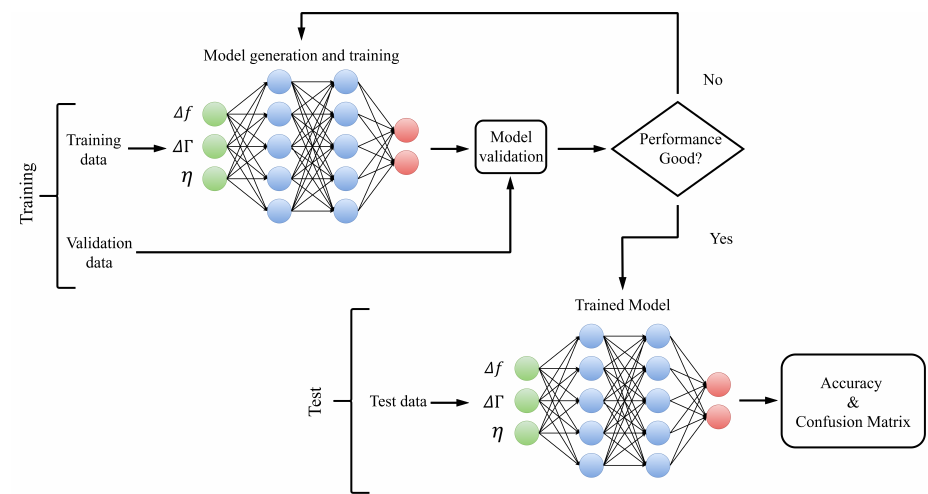
Figure 4. Training and test in the ANN model.